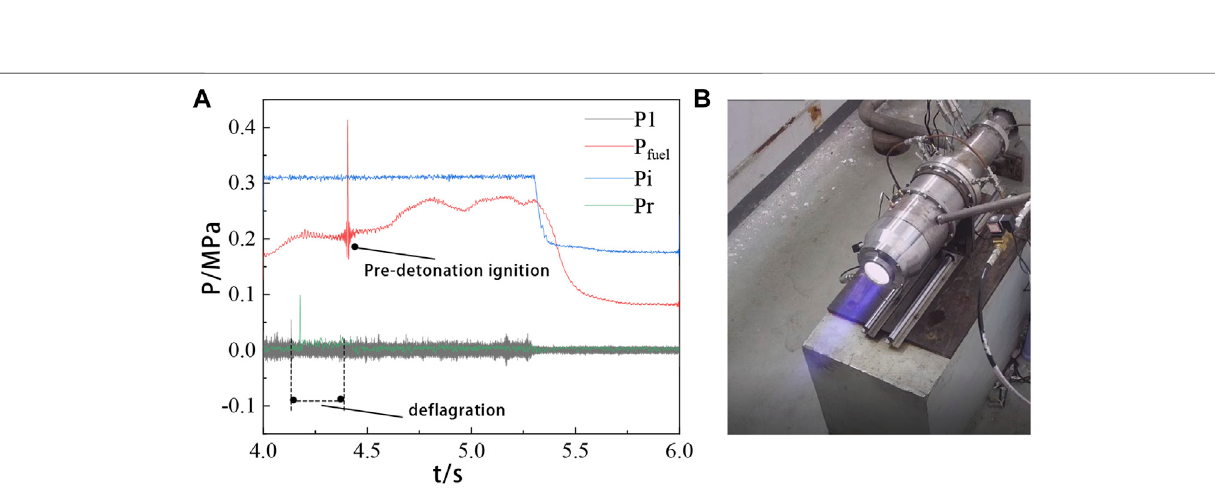
FIGURE 11 | Results ofoperating at T 0 (cid:1) 480K, _ m air (cid:1) 1 . 5kg/s, φ (cid:1) 0 . 98. (A) Static pressure signals and high-frequency pressure signals by P 1 ; (B) Local signals.